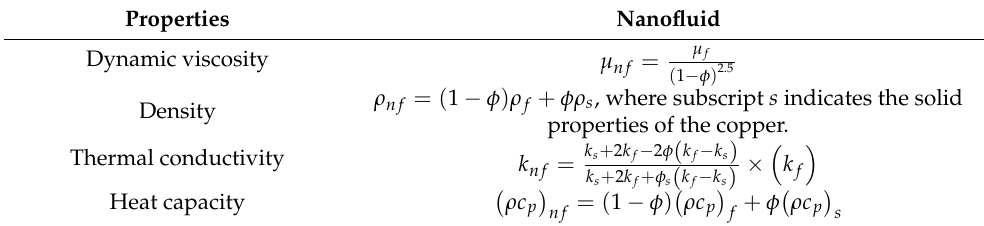
Table 1. Thermophysical properties of nanofluid [44].